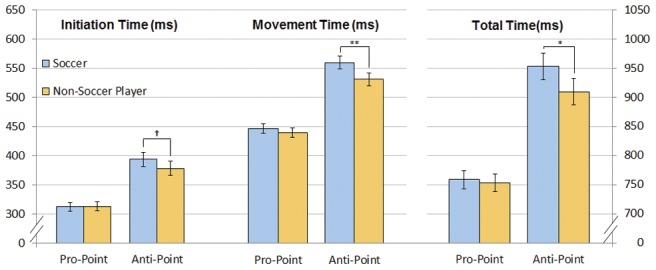
Estimated mean initiation, movement, and total reaction times for soccer and non-soccer subjects.Blue bars represent data from soccer players, and orange bars represent data from non-soccer players. Error bars indicate the 95% confidence interval (d.f. = 11). Note that the scale for total time (far right) is different from that of the initiation and movement times. Significance levels: (†) for p<0.1, (*) for p≤0.01, and (**) for p<0.005.